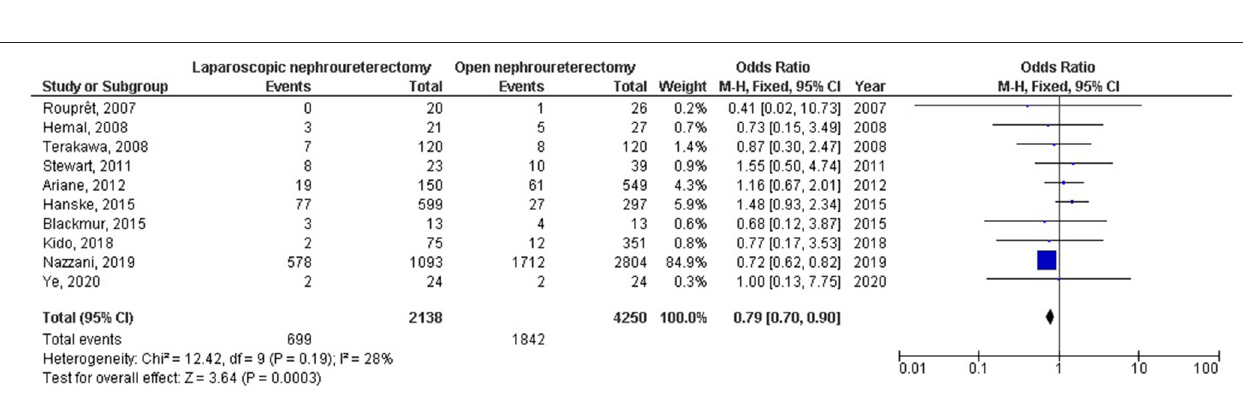
FIGURE 7 | Forest plot of the effect of open nephroureterectomy compared with laparoscopic nephroureterectomy on 2–5 years recurrence-free survival in subjects with upper urinary tract urothelial carcinoma.